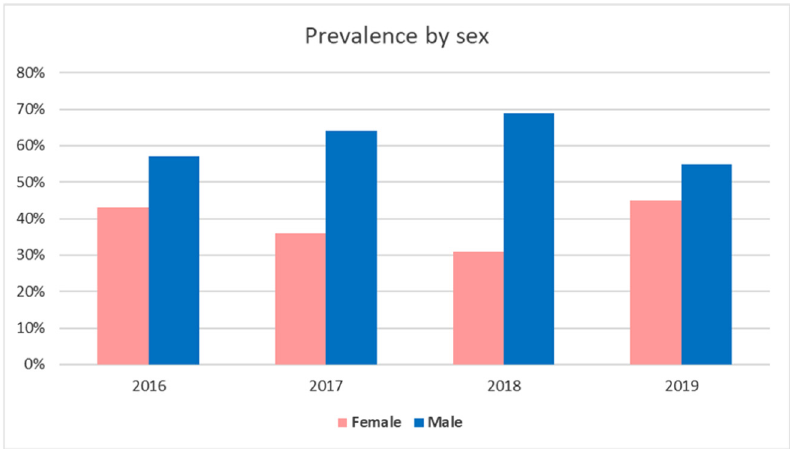
Figure 2. Prevalence of skin infection cases by study year associated with the sex of pets.